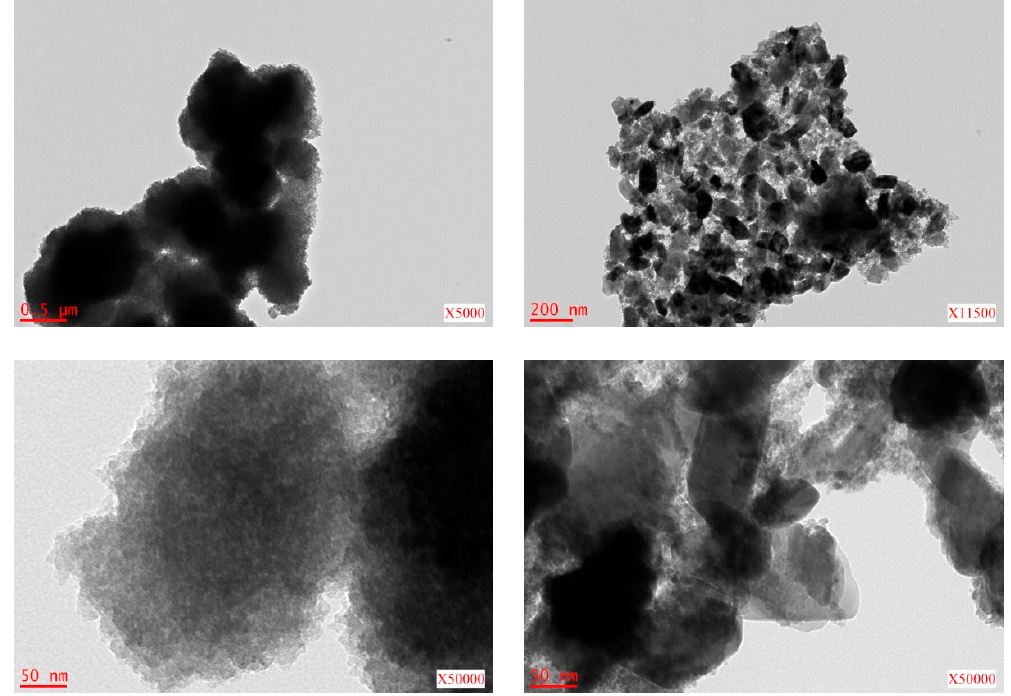
Figure 2. Materials produced by HTC of (NH 4 ) 2 Cr 2 O 7 –Mimosa tannin solution at different magnifications: before ( left ) and after ( right ) calcination in air; TEM pictures.